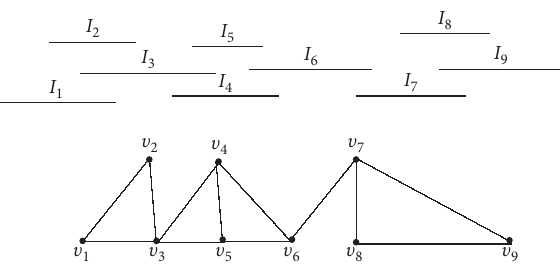
Figure 3: An interval representation and its corresponding